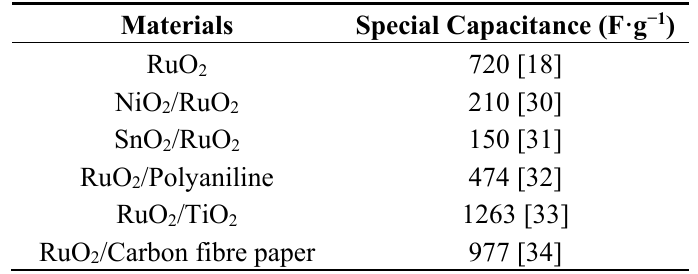
Figure 2. Cyclic voltammogram (CV) of RuO 2 · x H 2 O electrodes annealed at 150 °C. The voltage scan rate was 2 mV·s − 1 , and the electrolyte was 0.5 M of H 2 SO 4 [18]. Table 1. The special capacitances of hybrid RuO 2